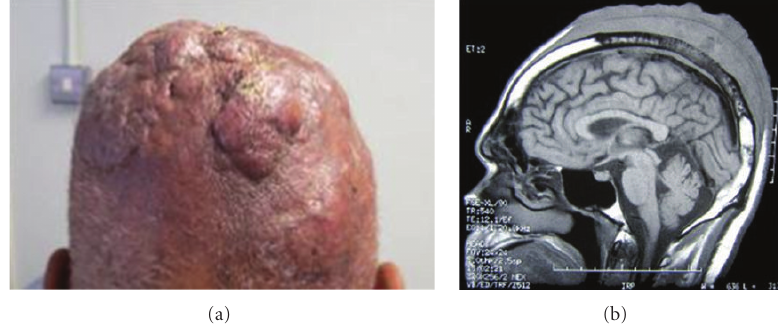
Figure 1: (a) Scalp nodules as seen at presentation. (b) MRI demonstrating an extensive mixed signal, soft tissue mass, over the vertex of the skull. There is infiltration through the inner and outer tables of the skull vault and extension into the dural membranes.